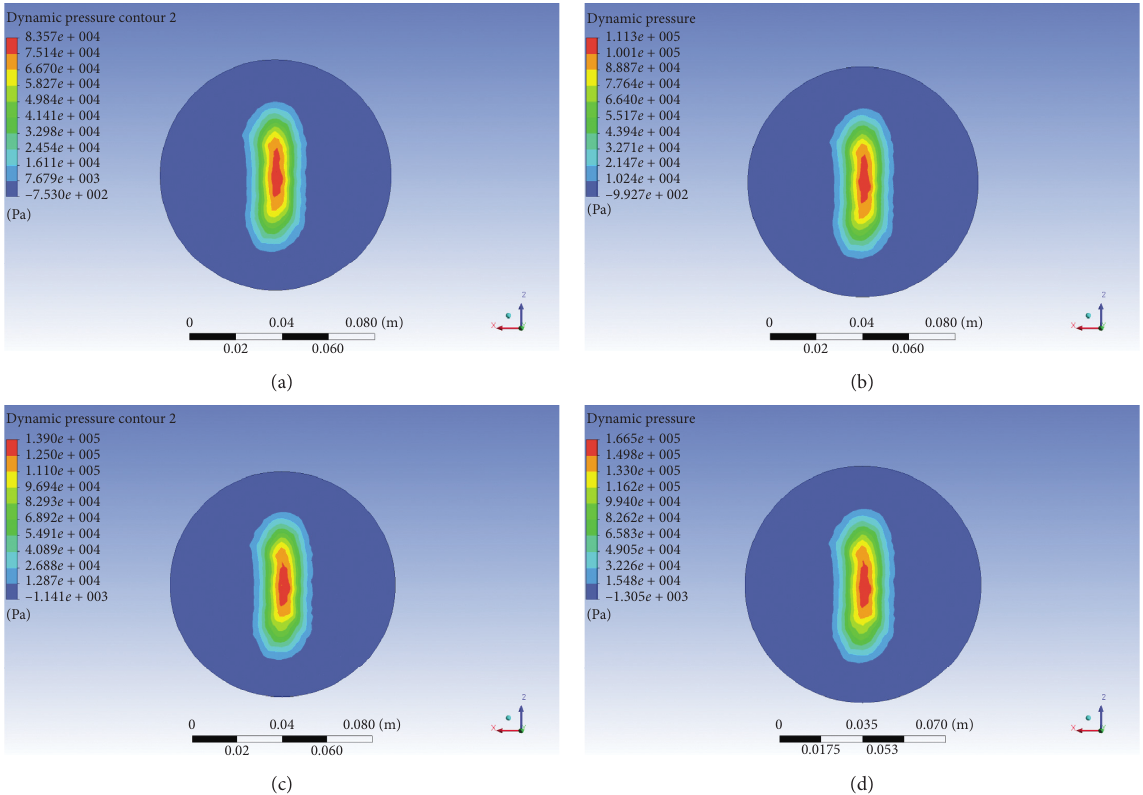
Figure 8: Target dynamic pressure nephogram under different inlet pressure. (a) 6 MPa. (b) 8 MPa. (c) 10MPa. (d) 12MPa.